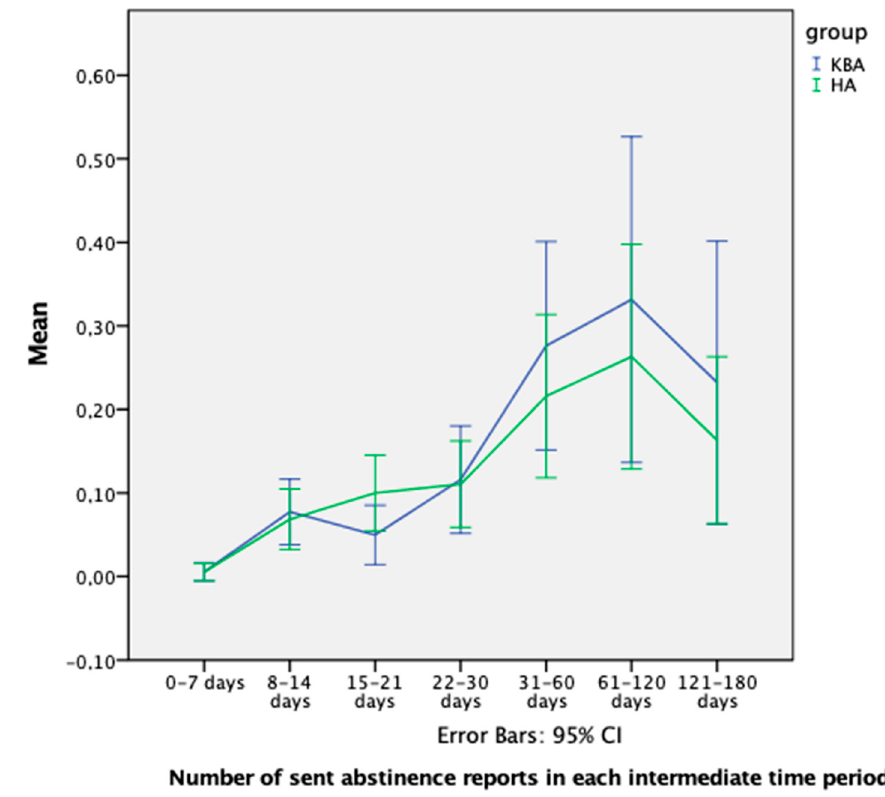
Figure 6. Evolution of the number of sent abstinence reports (higher is